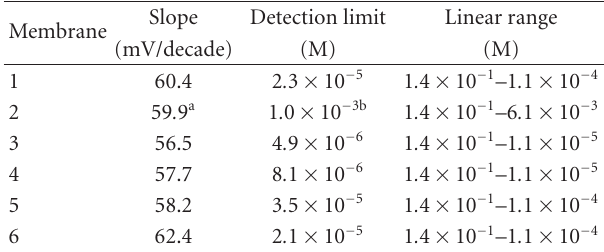
Table 2: Response characteristics of the Cs + -selective electrodes studied in this